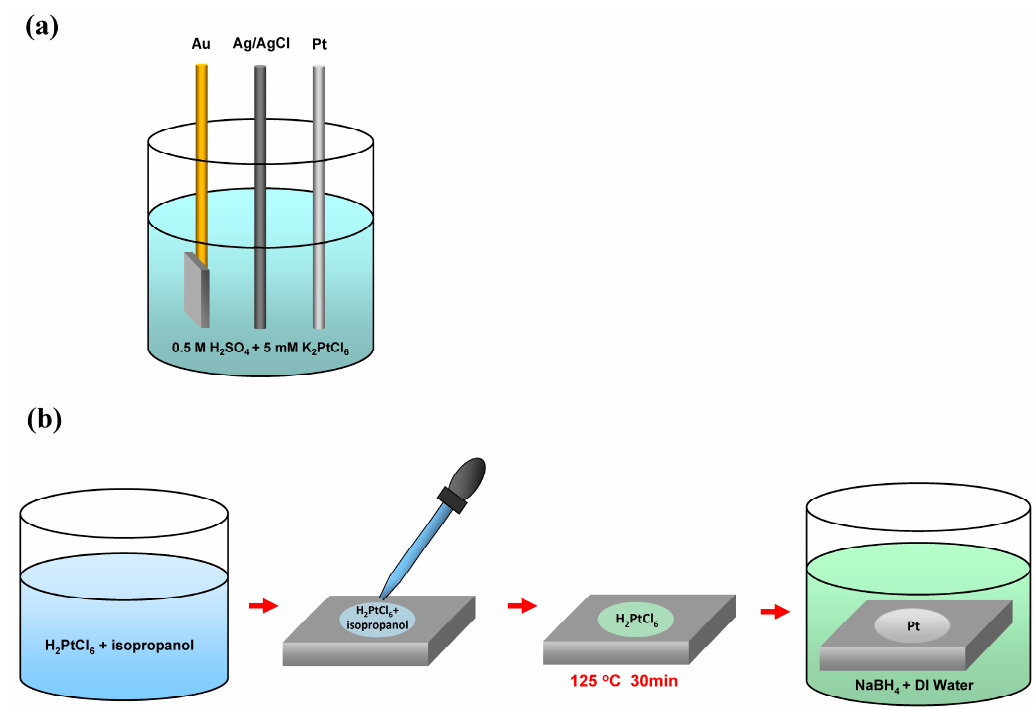
Figure 1. ( a ) Three-electrode electrochemical deposition apparatus used for preparation Pt counter electrode and ( b ) the preparation process of the Pt counter electrode by chemical reduction. The preparation process of the Pt counter electrode by chemical reduction is shown in Figure 1b.